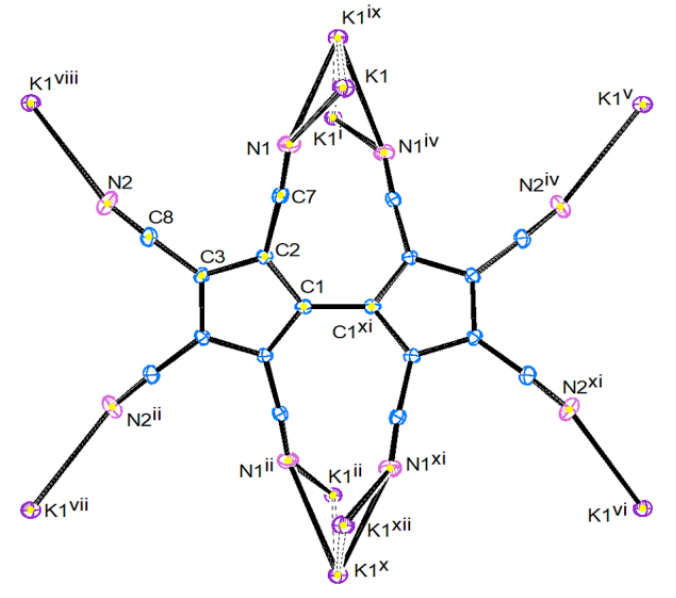
Figure 14. A complete octacyanofulvalenediide dianion with all coordinated K + ions. Symmetry op-